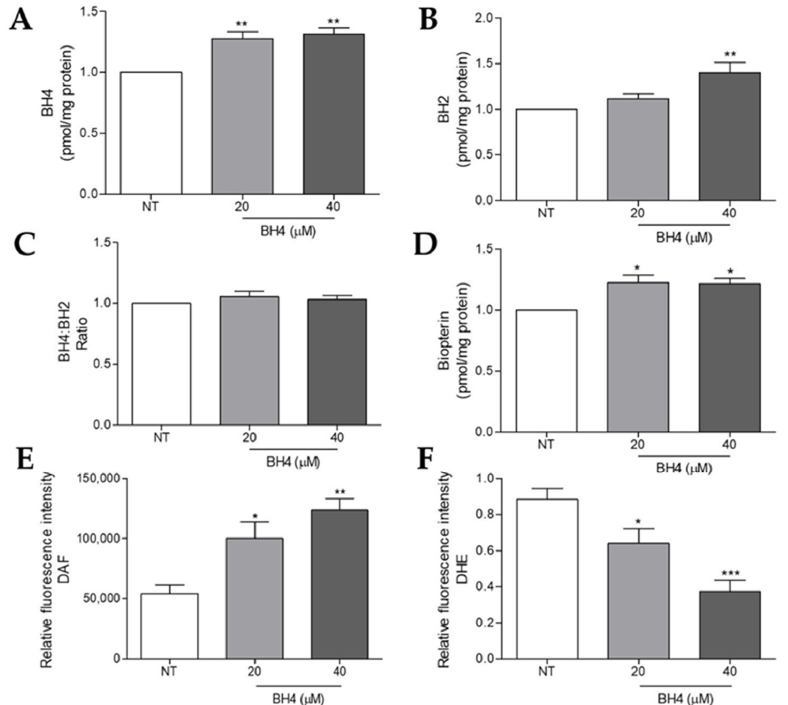
Figure 5. Tetrahydrobiopterin treatment restored the intracellular BH4 and recoupled NOS activity in radial growth melanoma cells. WM1552C cells were treated or not for 16 h with 20 and 40 µM BH4 and the amounts of BH4 ( A ), BH2 ( B ), BH4:BH2 ratio ( C ), and total biopterin ( D ) were determined by HPLC. The NO amount was evaluated by flow cytometry using DAF ( E ) and the O 2• − levels using DHE ( F ). Values are reported in the bar graphs and expressed as the means ± S.D. The experiments were performed in triplicate, and the p -values were based on the one-way ANOVA test, followed by Bonferroni’s post-test. * p < 0.05, ** p < 0.01 and *** p <